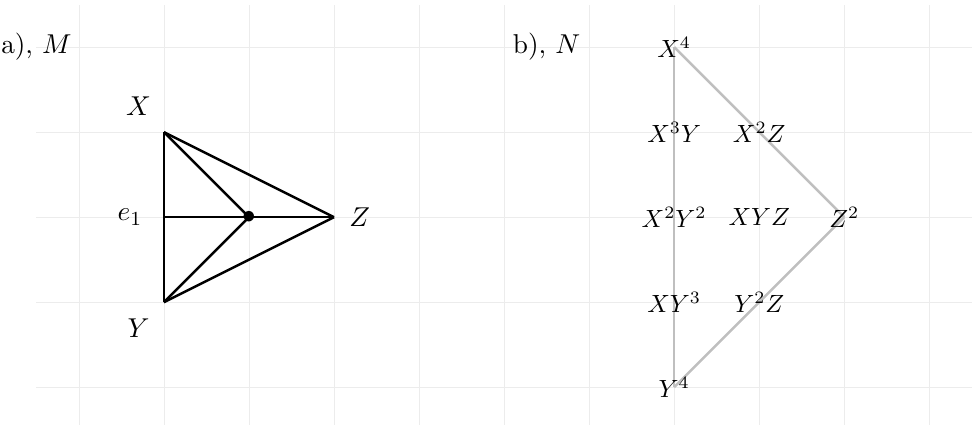
Figure 5 . The dual pair of polytopes F 4 and F 13 is shown in a) and b). We also indicate the toric fan obtained from a complete star triangulation of F 4 and labelled the homogeneous coordinates. In the monomials that correspond to points of F 13 we have set e 1 = 1. The dependence can be easily